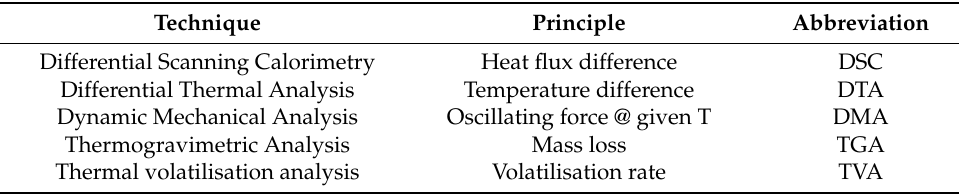
Table 1. Popular techniques of thermal analysis. Technique Principle Abbreviation Differential Scanning Calorimetry DSC Differential Thermal Analysis Temperature difference Dynamic Mechanical Analysis Oscillating force @ given T Thermogravimetric Analysis Mass loss Thermal volatilisation analysis Volatilisation